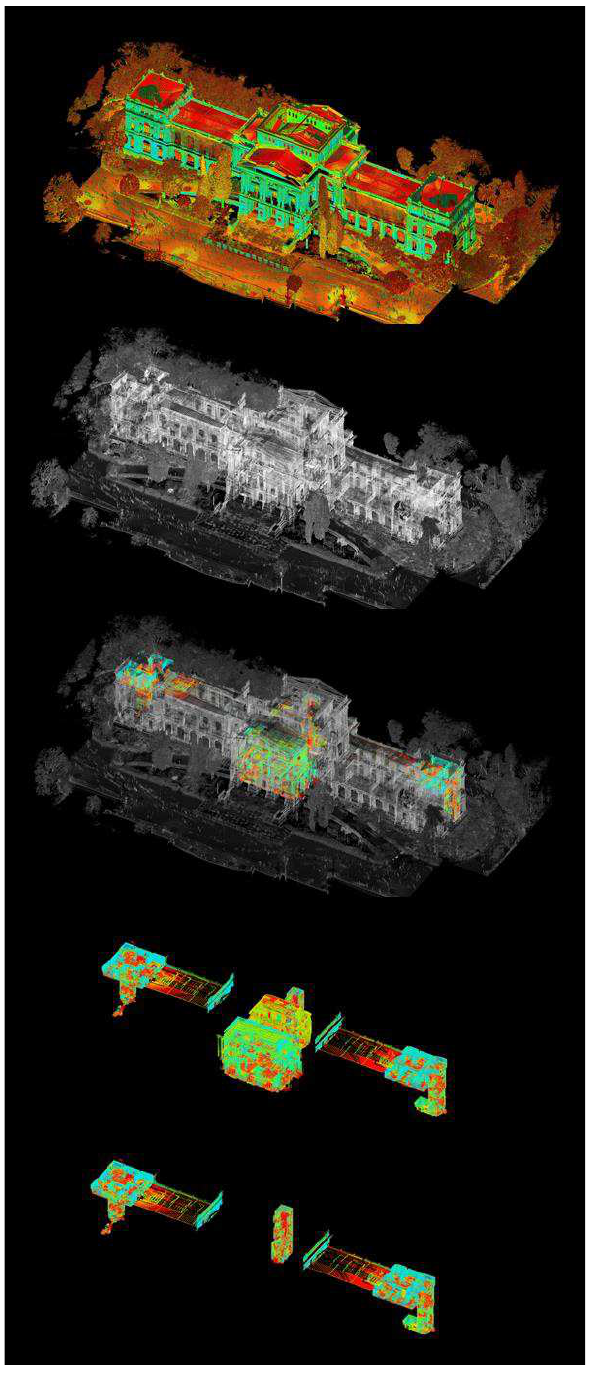
Figure 3. Integrated digital database and three-dimensional point cloud model hierarchy and structure implemented through traditional procedures and the use of 2D and analogue representation